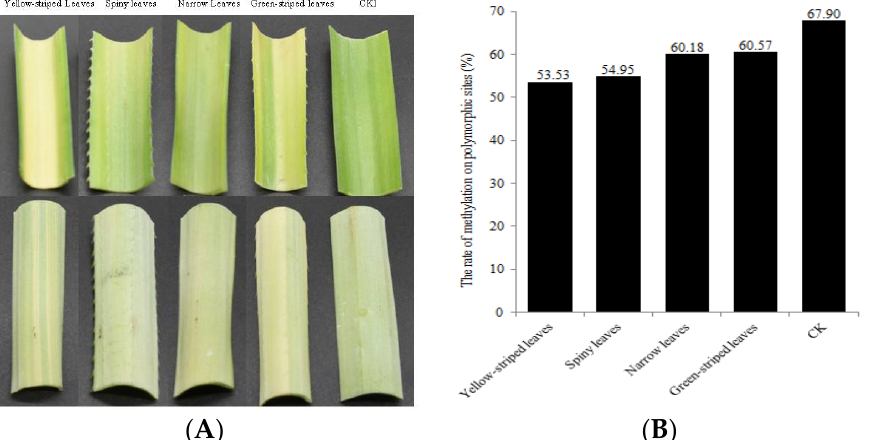
Figure 1. The change of leaf phenotype and rate of methylation sites in somaclonal variation. ( A ) The phenotype of the CK and somaclonal variation plants. ( B ) The rate of methylation on polymorphic sites in leaf type variants.